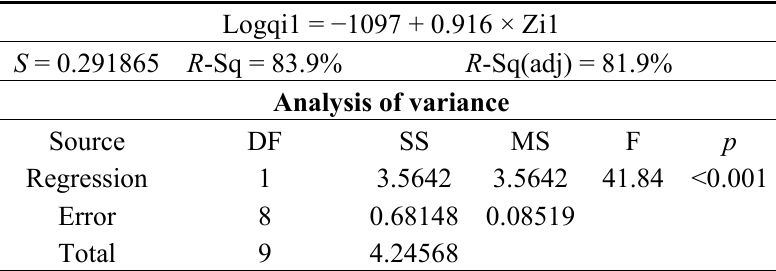
Table 2. Regression analysis: Logqi1 vs .